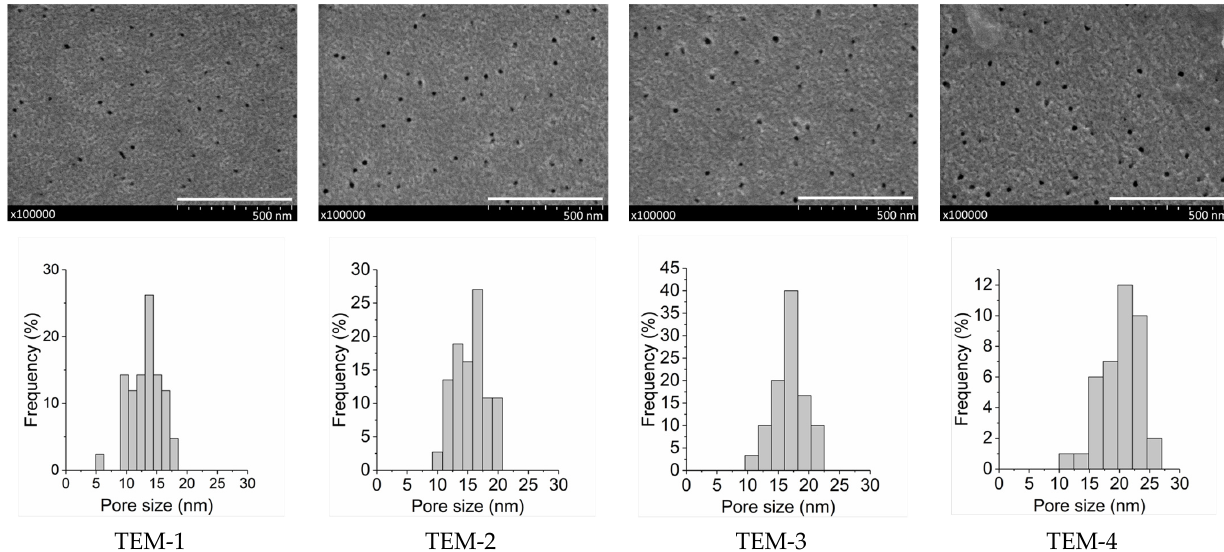
Figure 3. SEM images ( top ) and pore size distributions ( bottom ) of side a of membranes TEM-1, TEM-2, TEM-3 and TEM- 4 (from the left to the right). Scale bar, 0.5 μ m.